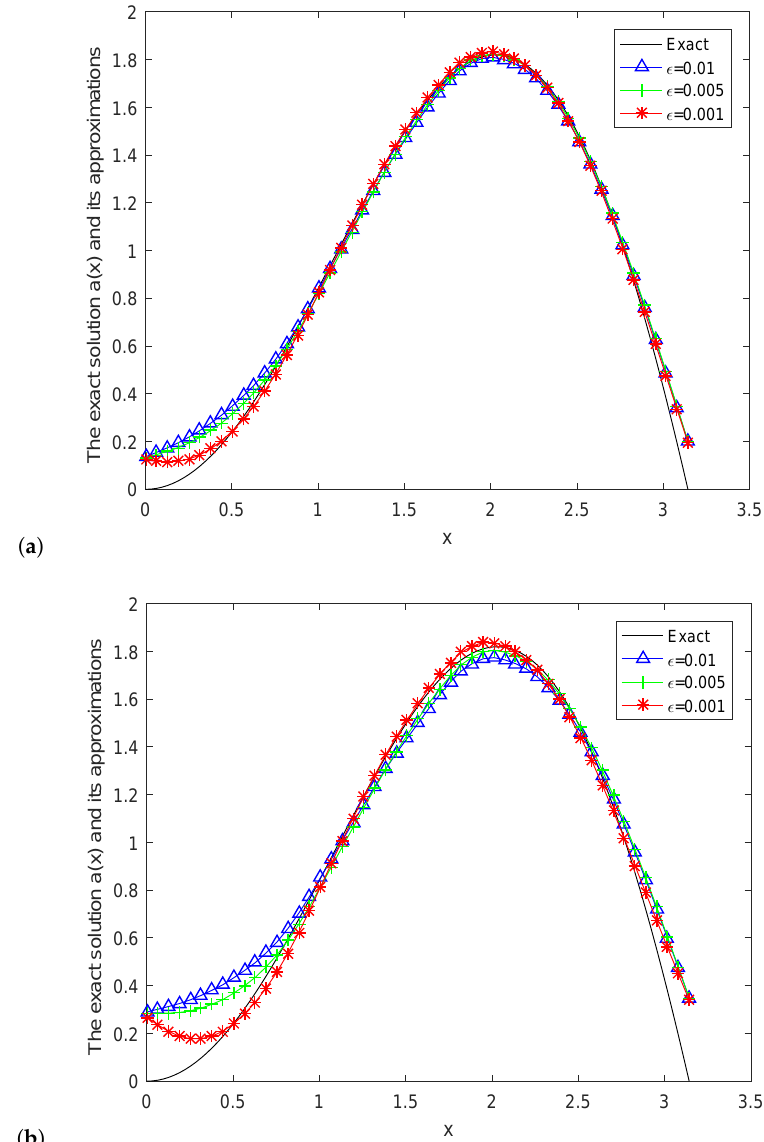
( x ) for Instance 1: ( a ) α = 1.2, ( b ) N 1